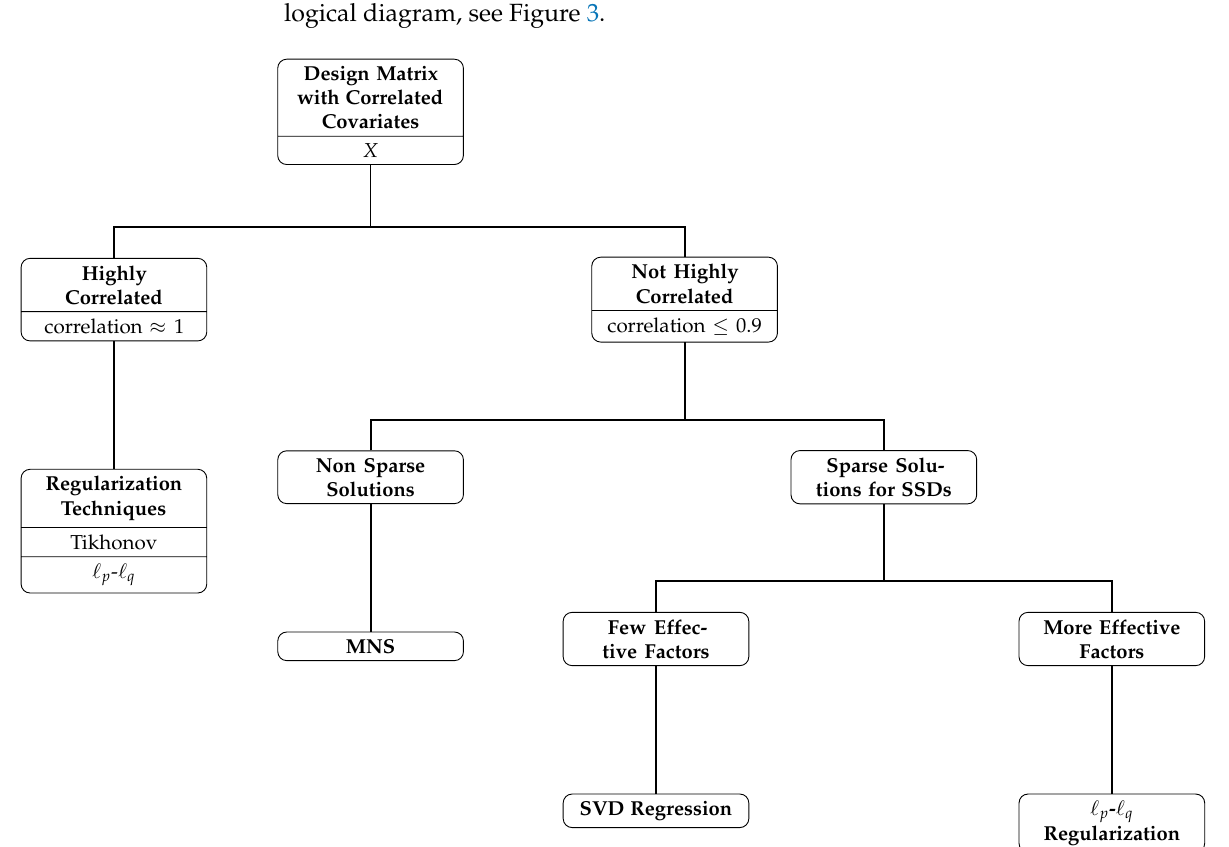
Figure 3. Logical diagram for choosing the appropriate method for the solution of high-dimensional statistical